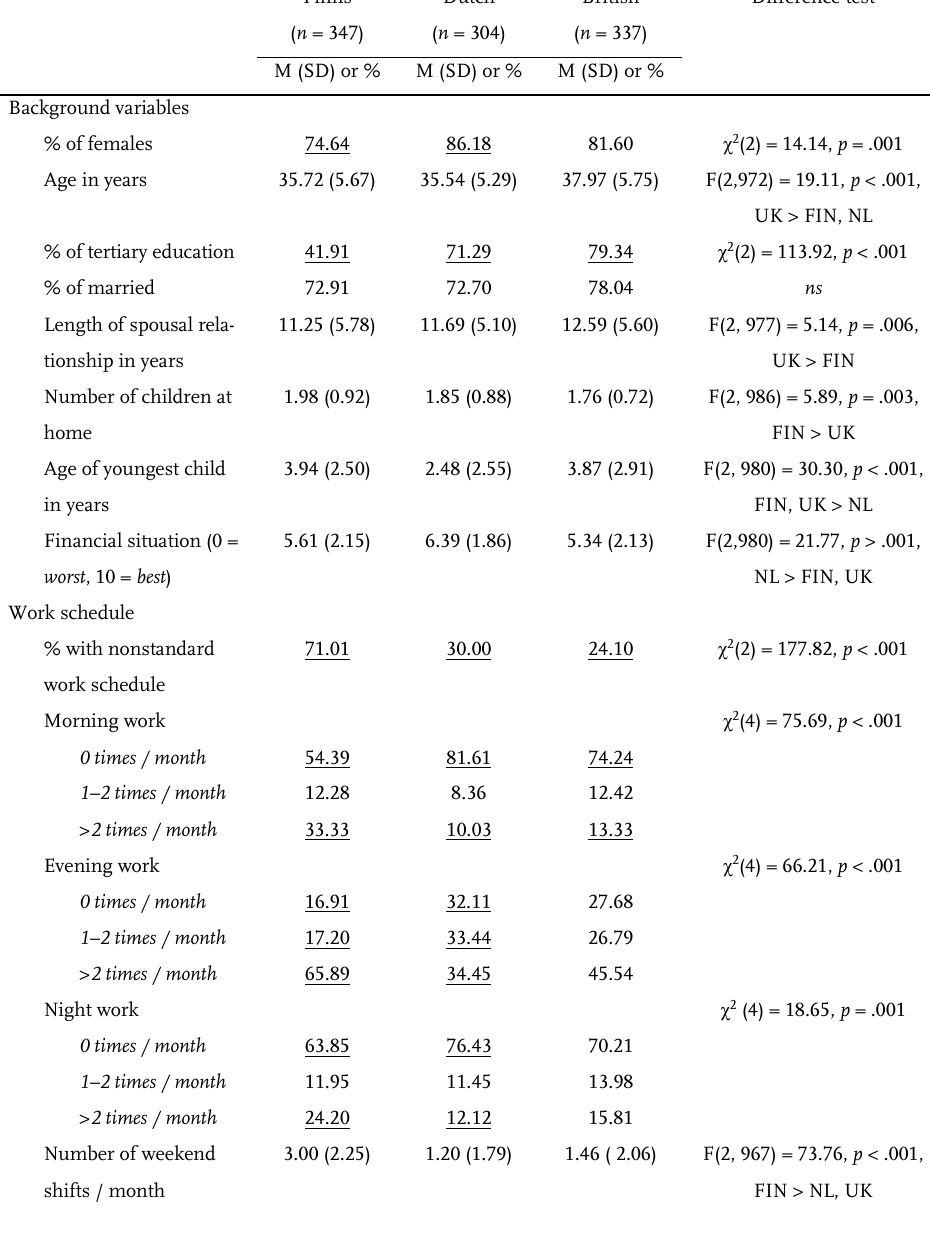
Table 1 : Background information on the Finnish, Dutch and British participants Finns ( n =